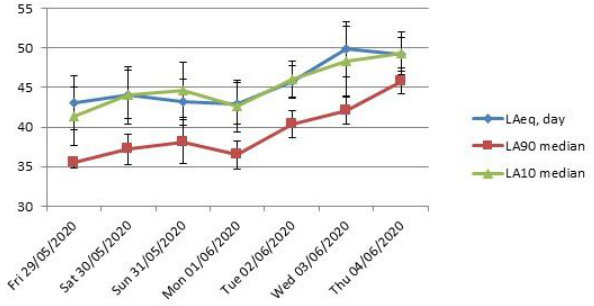
Figure 4: Case Study A: Day-time noise levels +/ − 1 standard devia- tion